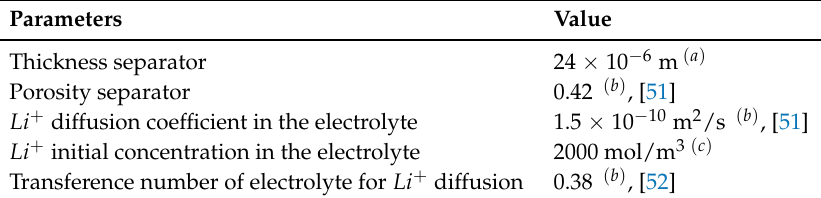
Table A3. Electrochemical parameters values: electrolyte and separator.